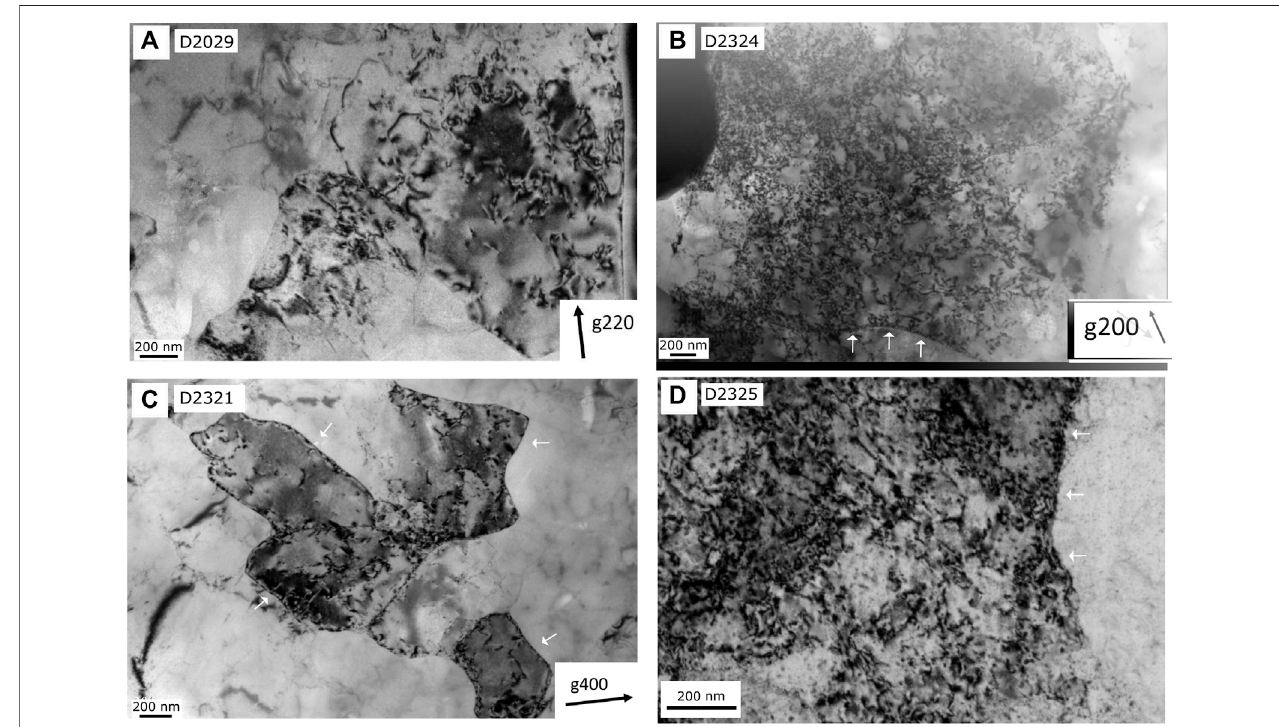
FIGURE 9 | TEM images illustrating dislocation microstructures at different conditions. (A) High temperature sample deformed at 1.6 GPa and 1,270 K; (B) moderate temperature sample deformed at 1,070 K and 1.8 GPa showing a forest of dislocations; (C) moderate temperature sample deformed at 875 K and 2.5 GPa showing numerous dislocations arranged in subgrain boundaries; (D) High pressure sample deformed at 1,070 K and 8.3 GPa showing a high dislocation density, image taken in multibeam conditions. The white arrows indicate examples of subgrain boundaries. The black arrows in the bottom-right corner indicate the g-vectors used for the bright fi eld images and their